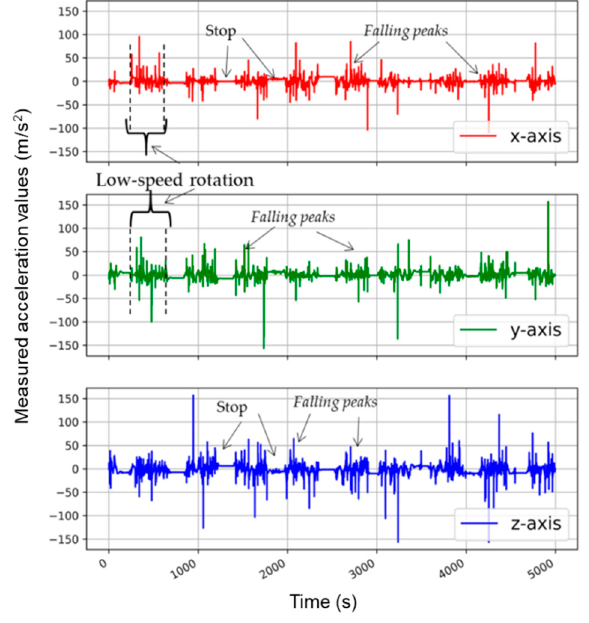
Figure 5. Accelerometer analysis in the washing phase (low-speed rotation).